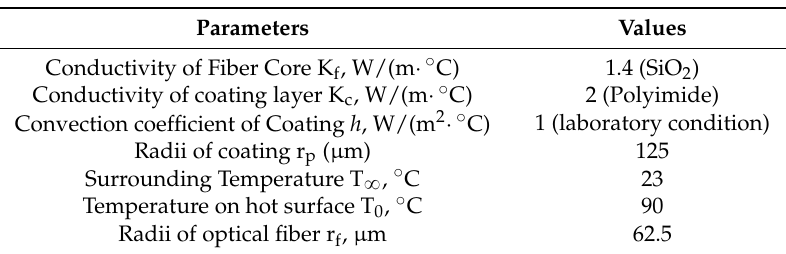
Table 1. Parameters in the numerical simulation.